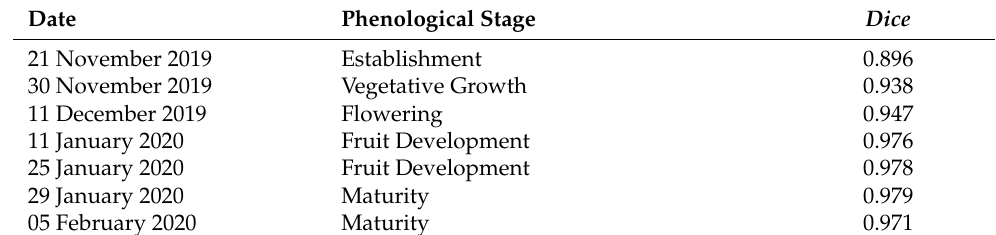
Table 3. Quality assessment of the segmentation algorithm. Comparison between manual and automatic NDVI map segmentation for different tomato phenological stages.